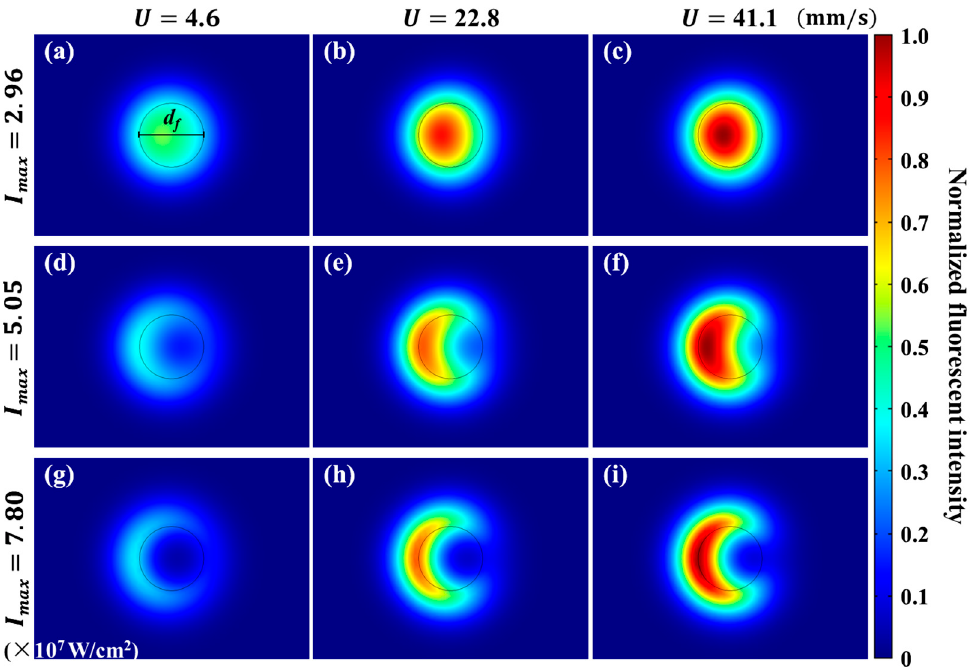
Figure 6. Distribution of fluorescent intensity 𝐼 (cid:3033),(cid:2922)(cid:2925)(cid:2913)(cid:2911)(cid:2922) under different bulk flow velocities and laser power densities. ( a – c ) I f ,local under I max = 2.96 × 10 7 W/cm 2 , with U = 4.6, 22.8, 41.1 mm/s, respectively. ( d – f ) I f ,local under I max = 5.05 × 10 7 W/cm 2 , with U = 4.6, 22.8, 41.1 mm/s, respectively. ( g – i ) I f ,local under I max = 7.80 × 10 7 W/cm 2 , with U = 4.6, 22.8, 41.1 mm/s, respectively. Here, the legend is normalized by the peak fluorescent intensity. The black circle represents the integration region of fluorescence to calculate 𝐼 (cid:3033) .